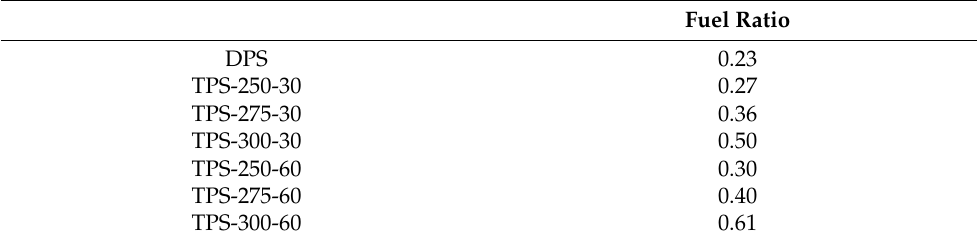
Table 3. Fuel ratios of dried and torrefied pulp industry